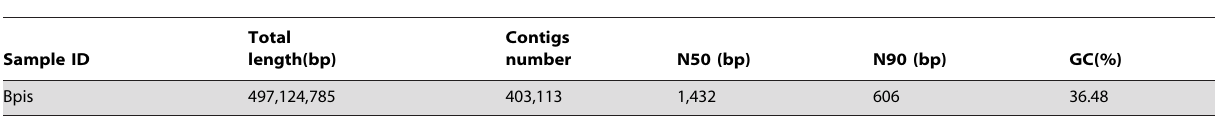
Table 5. Final assembly of adzuki bean weevil genome.